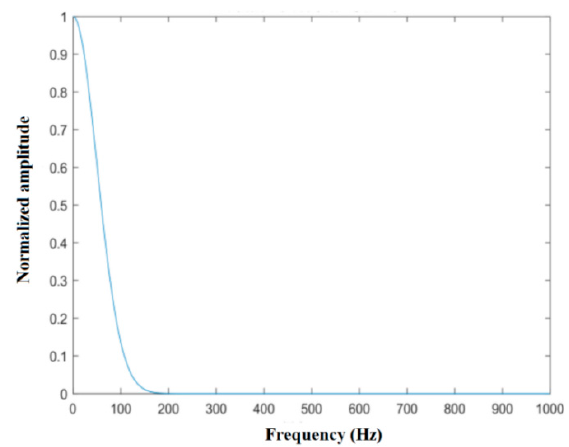
Figure 6. Spectral density curve of the Gaussian power spectrum.